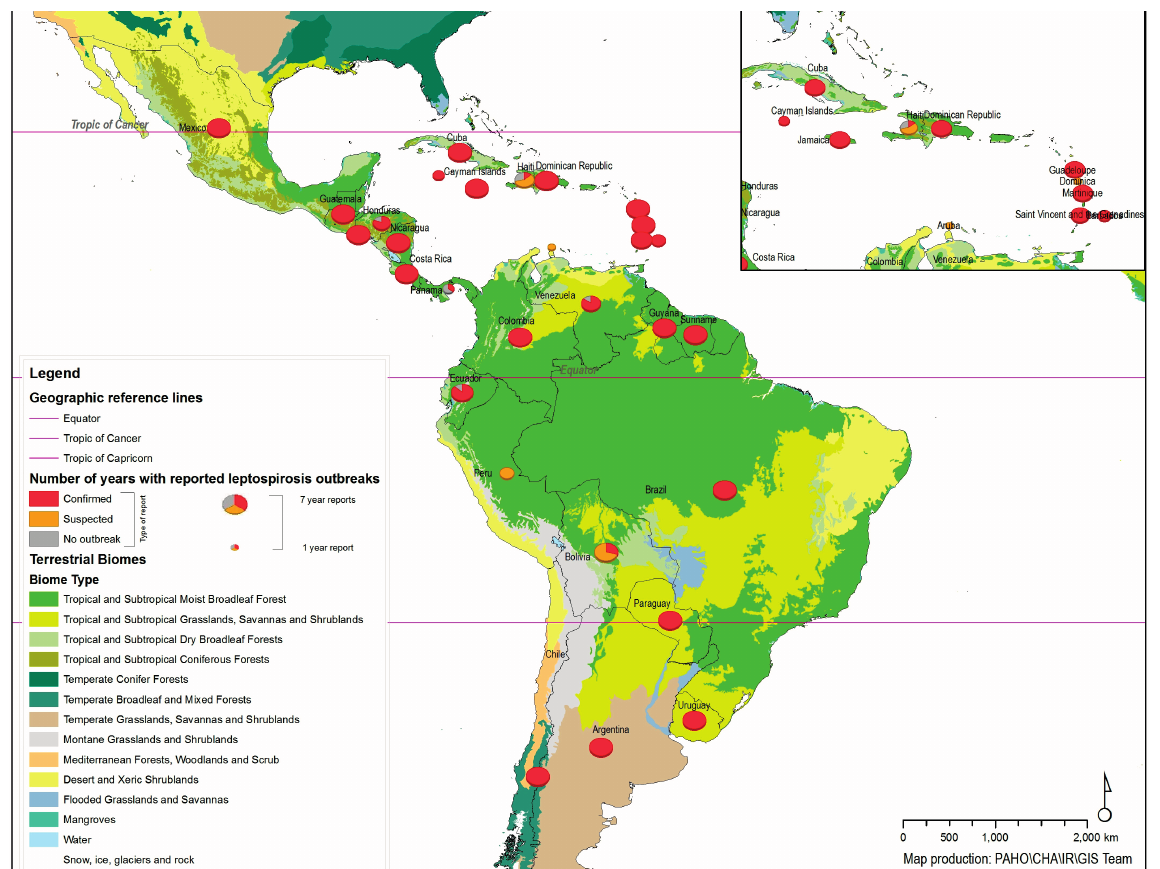
Figure 1. Geographic distribution of animal leptospirosis outbreaks reported to the World Organization for Animal Health (OIE) from